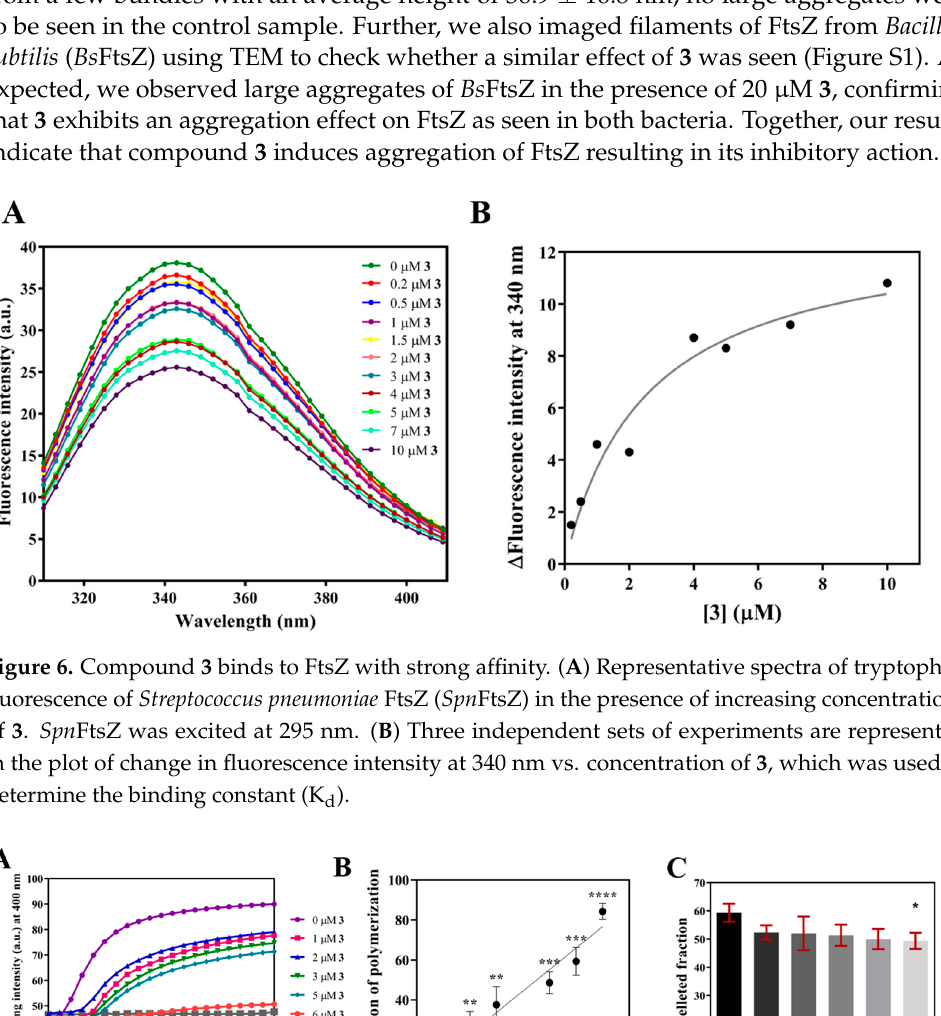
Figure 5. Enol 3 has no effect on the membrane or morphology of B. subtilis and S. pneumoniae cells. ( A ) Fluorescence (FM-4-64 channel) and DIC-merged laser scanning confocal microscopy images of Bacillus subtilis 168 cells stained for membrane using FM-4-64 dye after treatment with and without 8 µM 3 for 10 min. The images are representative of 300 cells imaged in each case. Scale bar indicates 2 µm. ( B ) Scanning electron microscopy images of fixed S. pneumoniae TIGR4 cells treated with, or without, 2 µM 3 for 1 h. The cells shown are representative of 100 cells imaged in each case. Scale bar indicates 2 µm.